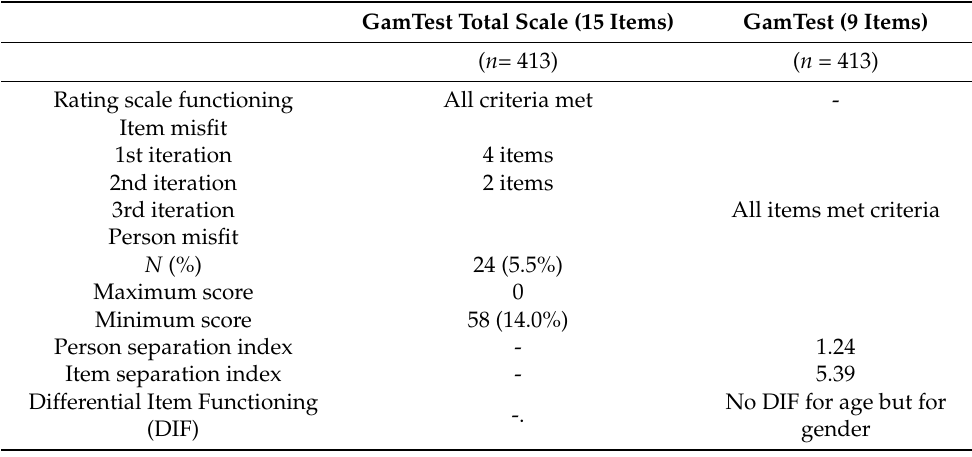
Table 1. The psychometric properties of the